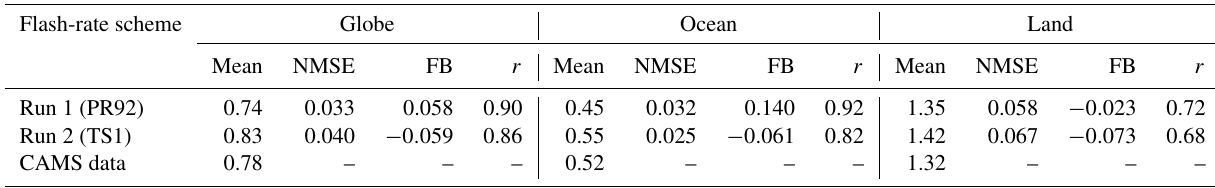
Figure 9. Zonal-averaged total tropospheric NO 2 column (N v , trop ) (in units 10 15 moleculescm − 2 ) modelled using the default PR92 param- eterisations (Run 1), the new lightning flash-rate parameterisations from this study (Run 2), and the CAMS reanalysis data for the year 2006 over (a) globe, (b) ocean, and (c) land. The model variation without LNO x is also shown. Table 5. Mean (10 15 moleculescm − 2 ), NMSE, FB, and r for the modelled and CAMS reanalysis NO 2 columns shown in Fig. 9 for latitudes between ± 30 ◦